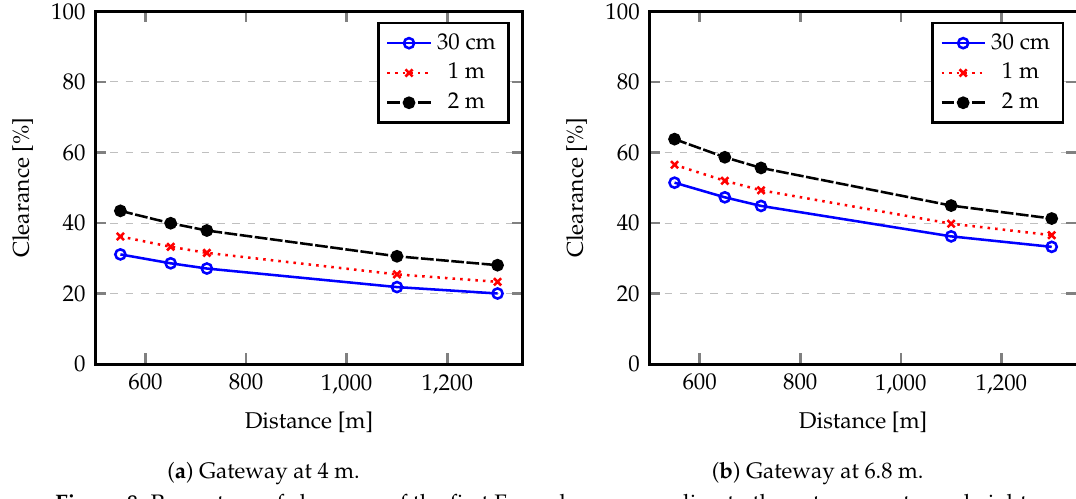
Figure 8. Percentage of clearance of the first Fresnel zone according to the gateway antenna